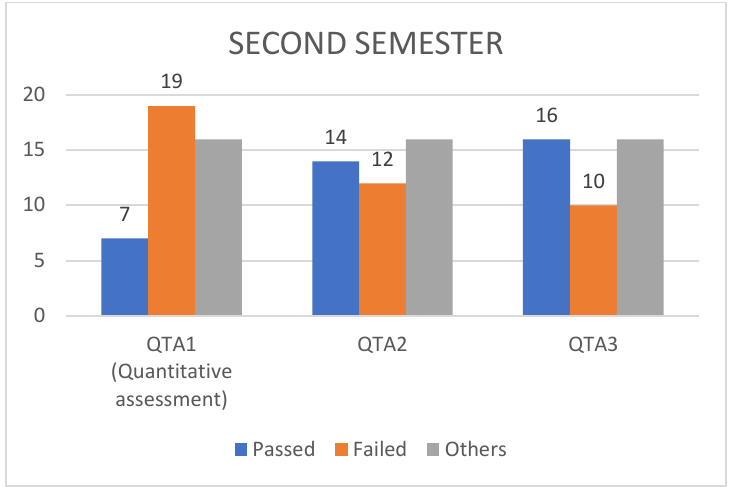
Fig. 3. Number of assessments given in the second semester. Source: Author. The graphs shown in Figures 3 and 4 denote behavioral changes and improvements in assessment